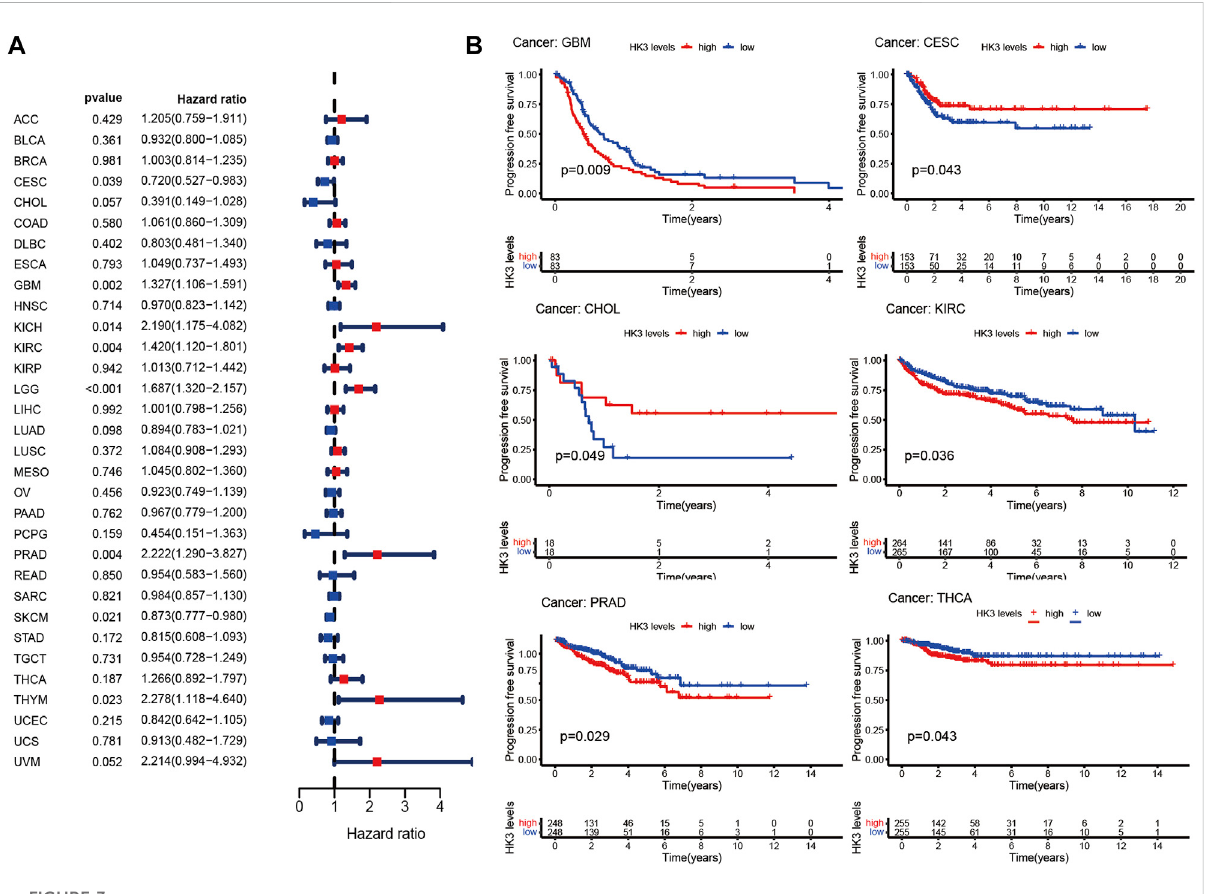
FIGURE 3 HK3 expression in33 different types of cancers in theTCGA databaseand PFS. (A) Forest plots ofunivariate Cox regression analysis; (B) Kaplan- Meier survival